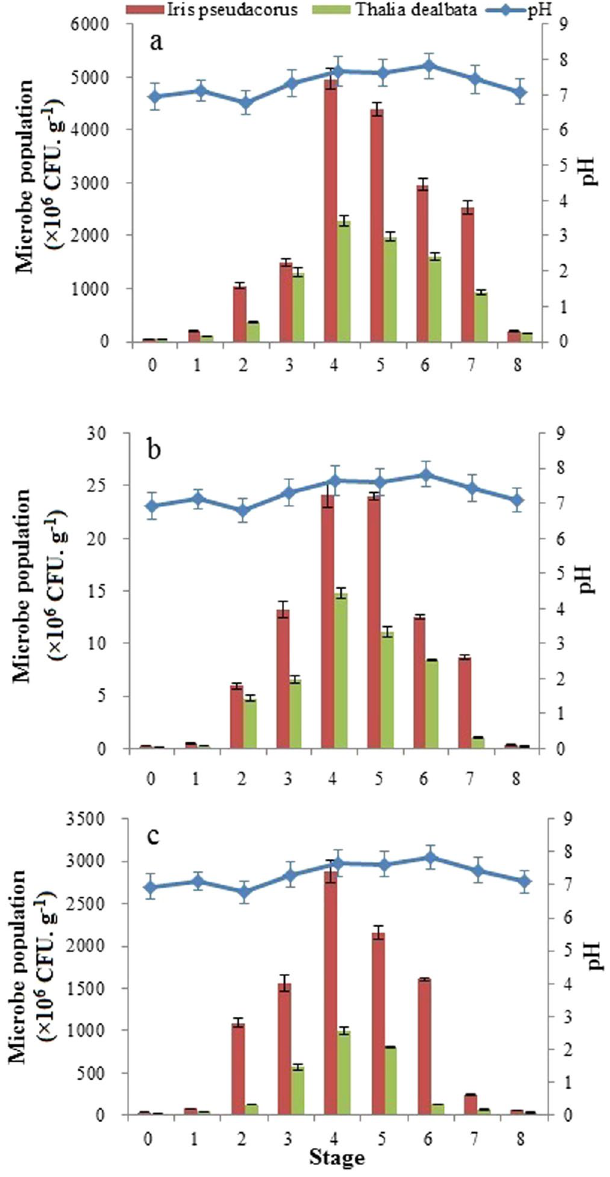
Figure 3. Microbial population in the rhizosphere of floating treatment wetland plants at various stages ( × 106 CFU∙g − 1 ), ( a ) bacteria, ( b ) fungi, ( c )